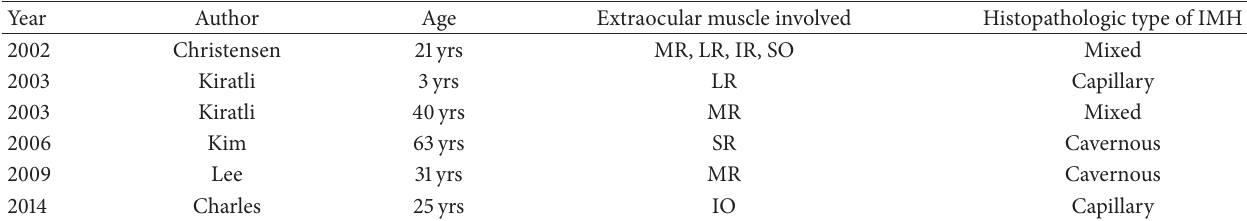
Table 1: Review of cases of “intramuscular hemangiomas” in extraocular